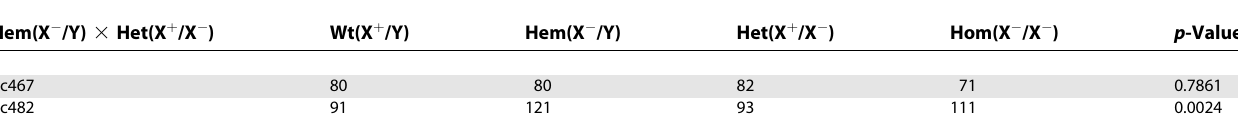
Table 3. Summary of Observed Offspring from Hemizygous 3 Heterozygous Mouse Crosses Hem(X (cid:2) /Y) 3 Het(X þ /X (cid:2) ) Wt(X þ /Y) Hem(X (cid:2) /Y) Het(X þ /X (cid:2) )